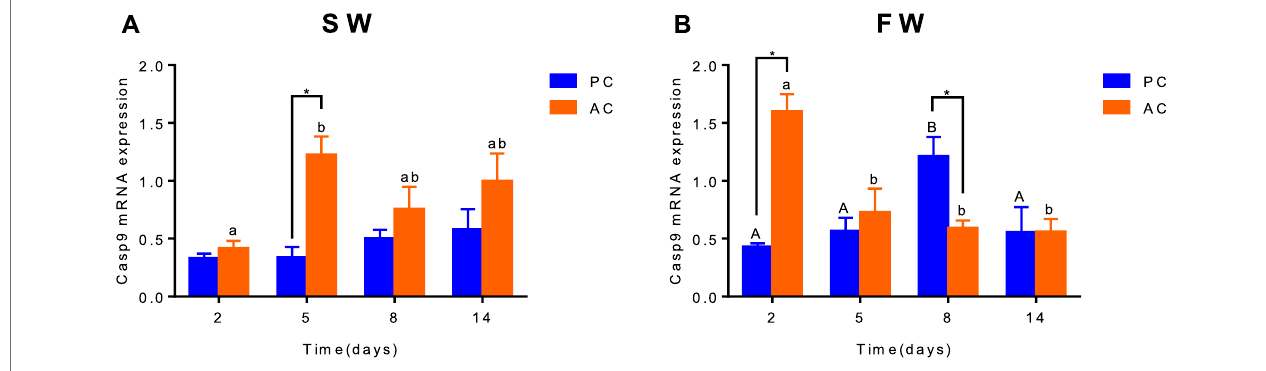
FIGURE5| Thebranchialgeneexpression of Caspase-9 inolive fl ounderwithpassivecopingstyle(PC)andactivecopingstyle(AC)aftertransferfromseawaterto seawater[SW, (A) ]andfreshwater[FW, (B) ].Dataaremean±SEM( n =6).Anasterisksigni fi esasigni fi cantdifferencebetweenthePCandACgroupsateachtimepoint ( p < 0.05). Different letters denote a signi fi cant difference across time within the same coping style group ( p <